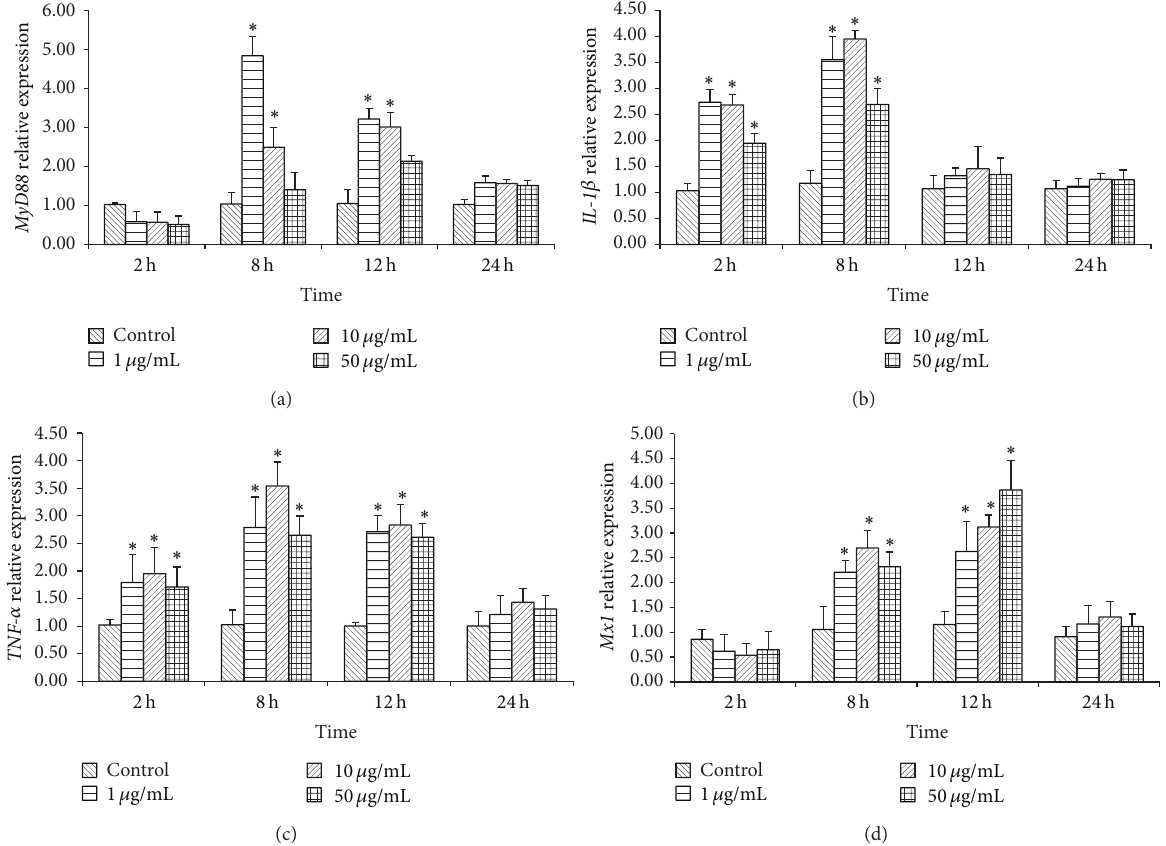
Figure3:Relativeexpressionofimmune-relatedgenesatdifferenttimepointsin C.idella headkidneymacrophages(CIHKM)cellsstimulated with SA. (a) Expression of MyD88 gene; (b) expression of IL-1 𝛽 gene; (c) expression of TNF- 𝛼 gene; (d) expression of Mx1 gene. Bars represent the mean ± S.E.M ( 𝑛 = 3 ). Significant expression levels in SA stimulated cells compared to unstimulated control are indicated by an asterisk ( ∗ ) at that time point ( 𝑃 < 0.05